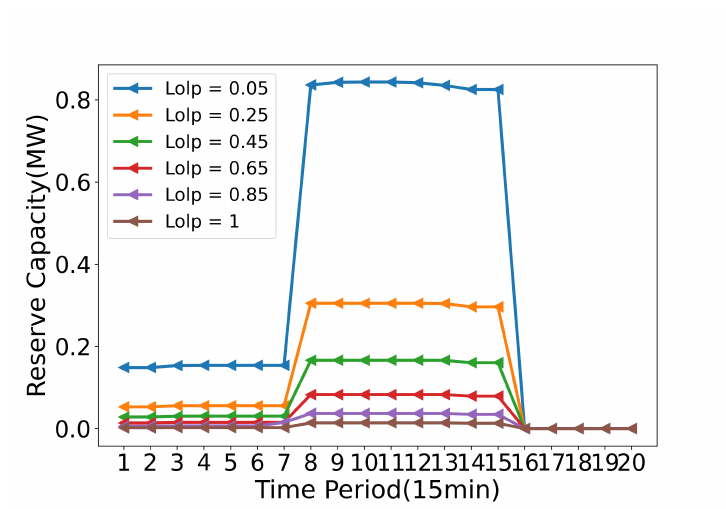
Figure 8. Reserve capacity under different Lolp levels.